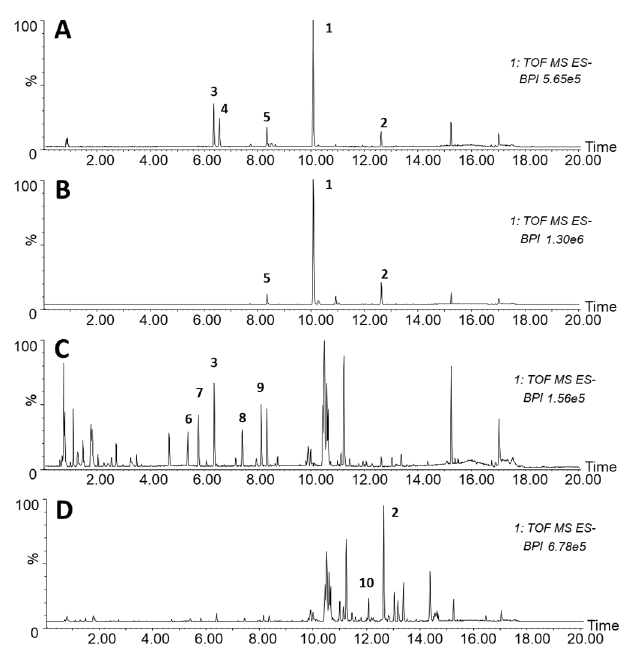
Figure 3. Negative LC-MS base peak chromatograms of C. colocynthis extracts. ( A ) : ethanol-extracted seed tegument (Teg-EtOH); ( B ) : adult leaves extracted in chloroform (Leaf-CHL); ( C ) : ethanol-extracted plantlets from in vitro cultures (PL-EtOH); ( D ) : chloroform-extracted plantlets from in vitro cultures (PL-CHL). Numbers indicate the following metabolites: (1) Cucurbitacin E 2-O-glucoside; (2) Cucurbitacin E; (3) Apigenin-6-C-glucoside; (4) Isoorientin 3 (cid:48) -O-methyl ether; (5) Cucurbitacin